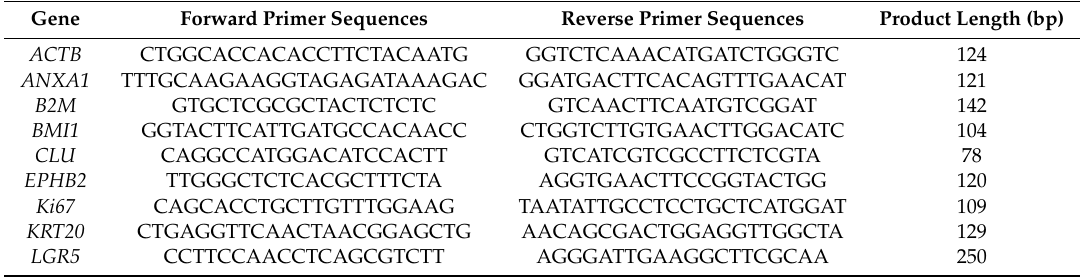
Table 2. List of primers used for qPCR